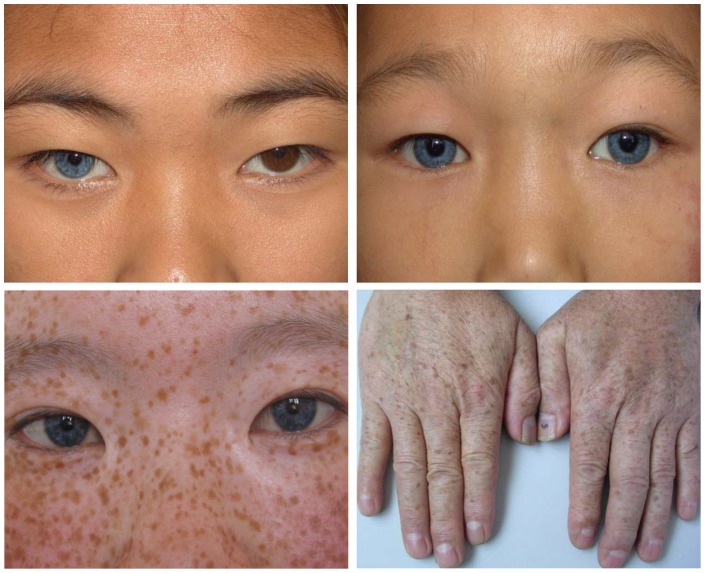
Photographs of some affected individuals.Upper left, the proband of family WS13 presented with complete heterochromia iridis. Lower left, the proband of family WS04 presented with bilateral blue irides and special brown freckles on the face. Upper right, the proband of family WS08 presented with bilateral characteristic brilliant blue irides. Lower right, individual II:7 of family WS01 had numerous freckles on the dorsum of the hands. (The subjects in the photographs provided written informed consent for publication of their photograph, as outlined in PLoS ONE consent form.).